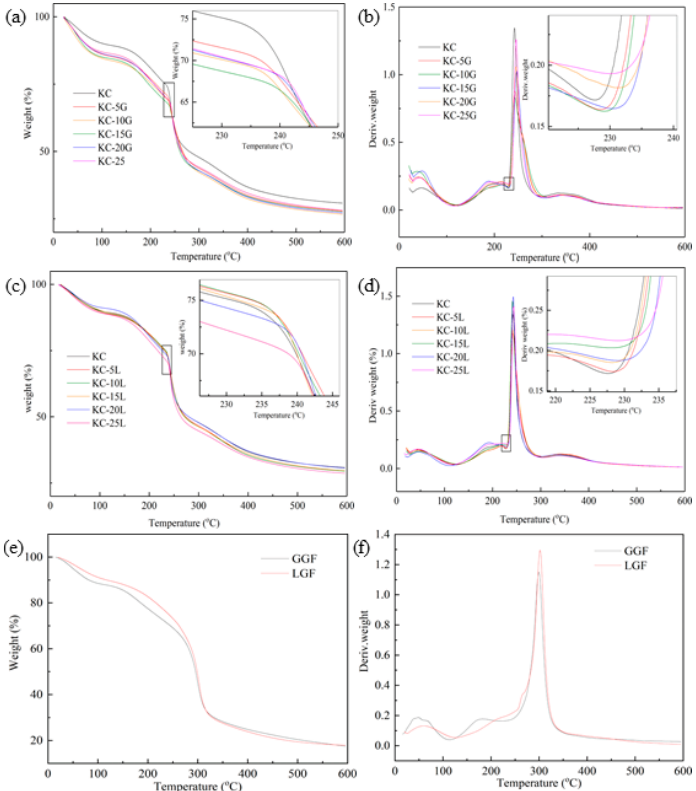
Figure 6. TGA ( a , c , e ) and DTG ( b , d , f ) curves of KC, KC-G, KC-L, GGF and LGF. Table 3. Decomposition parameters of KC, KC-G, KC-L, GGF and LGF. Sample